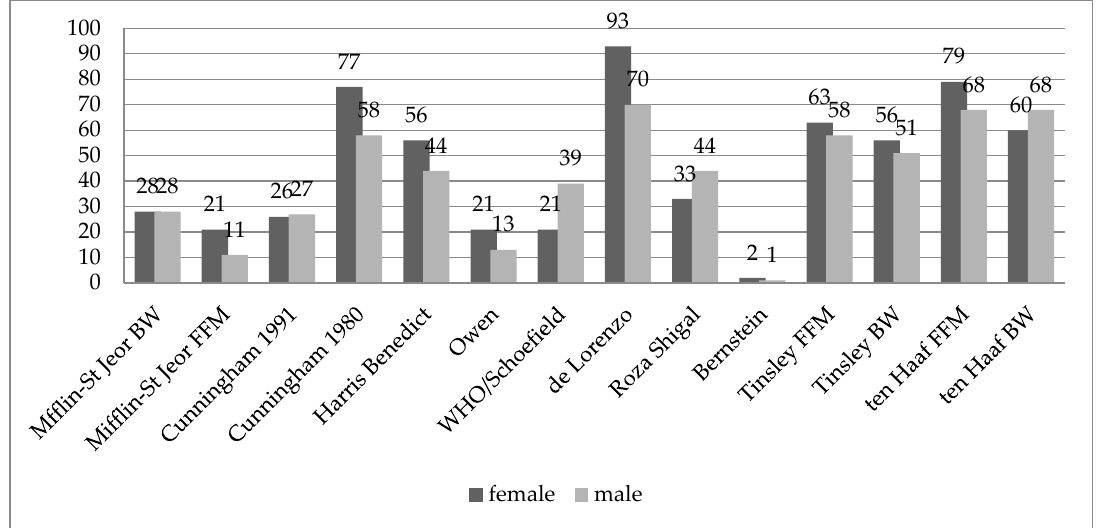
Figure 1. Percentage of studied equations overlapping by ±10% with IC measurement results for female group and male group.